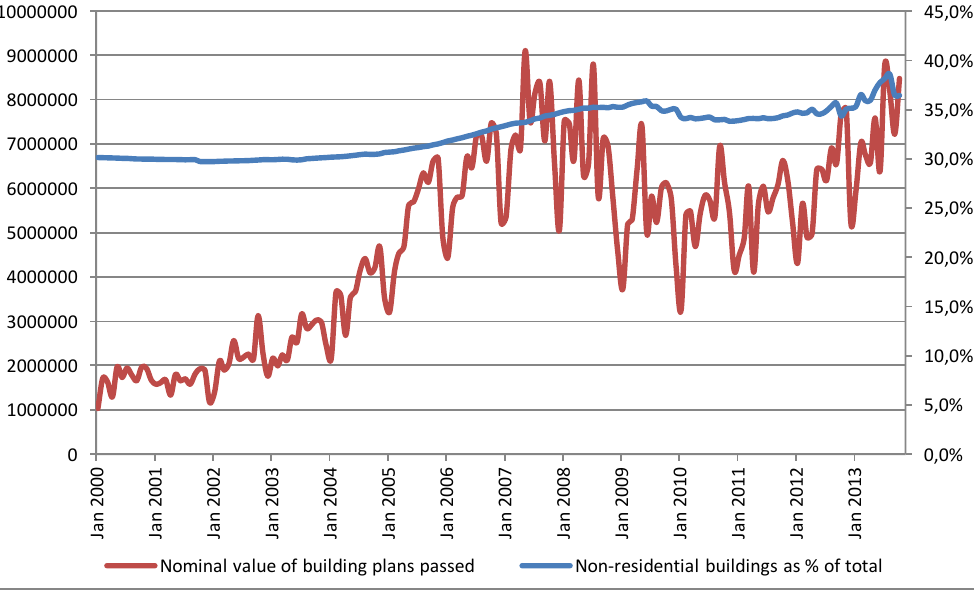
Figure 12 Total national building plans passed per month and Non-residential buildings plans passed as percentage of all property